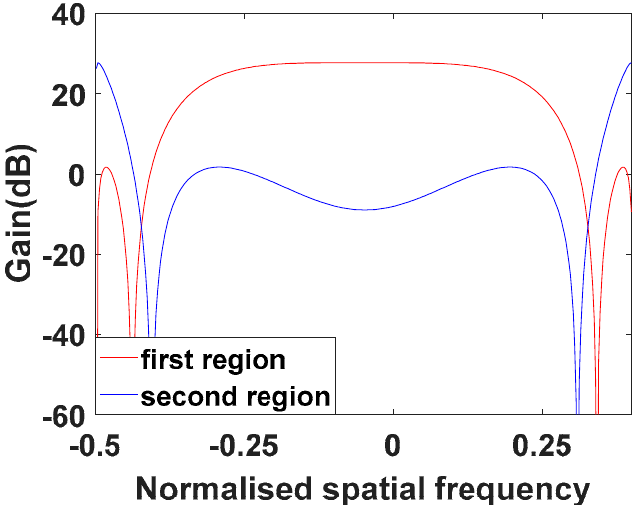
Figure 6. Filter response of the transmit beamformer designed for the first region.